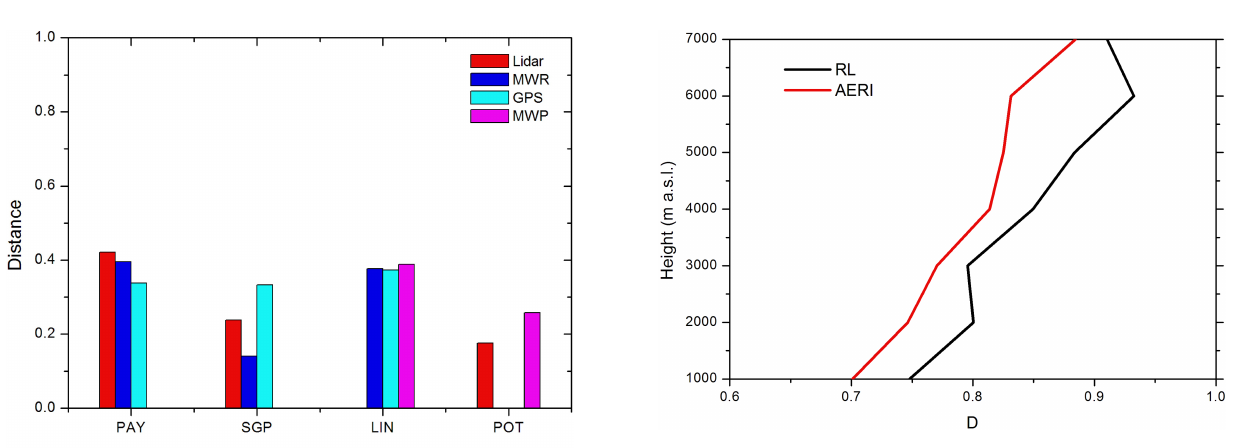
Figure 6. Comparison of the statistical distances of the Raman lidar (RL) and the atmospheric emitted radiance interferometer (AERI) time series from the RS92 radiosonde time series of water vapour vertical profile at the Southern Great Plains (SGP) site. The data set considered includes all measurements available at the SGP in 2010–2012, in 144